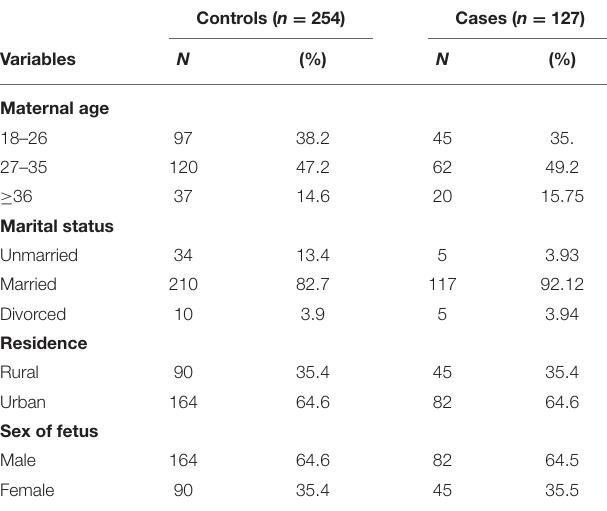
TABLE 2 | Frequency distribution of maternal and obstetric factors among case and control groups in Debre Berhan Specialized Hospital, 2021. Controls ( N =